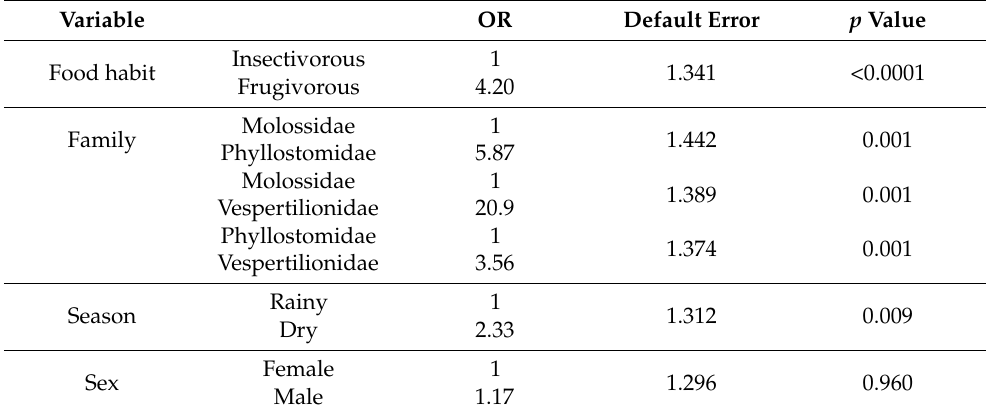
Table 1. Estimation of the odds ratio (OR) by logistic regression for the occurrence of positive rabies cases in bats according to food habits, family, sex and season of the year.